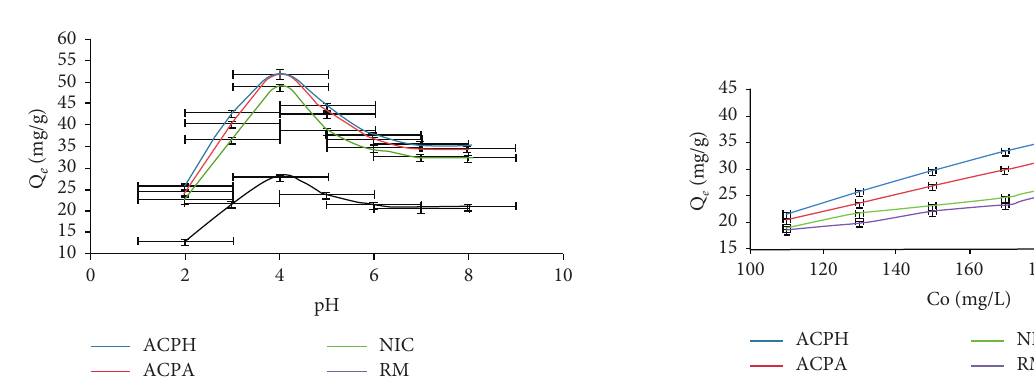
Figure 10: Effect of initial concentration on nickel(II) adsorption for ACPH, ACPA, NIC, and RM ( v � 20mL, t � 40min, pH � 4, adsorbent dose � 0.1g, stirring velocity